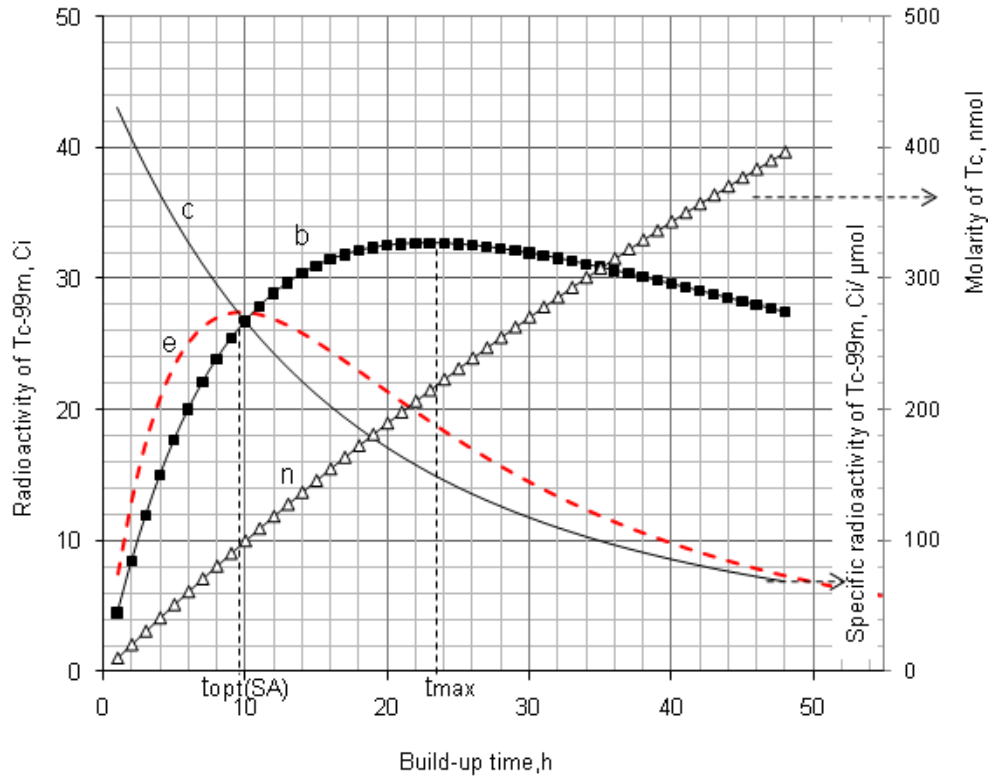
Figure 4. 99m Tc build-up optimisation of 99 Mo/ 99m Tc generator system: b, 99m Tc activity build-up (Referred to curve b of Figure 1); c, Specific radioactivity of 99m Tc (Referred to curve c of Figure 1); n, the total atom numbers N or molarities of Tc; e, Mean progress function of the 99m Tc-build-up versus specific activity of 99m Tc; t is the maximal build-up max is the optimal time value calculated in the optimisation time for nuclide 99m Tc; t opt ( SA ) process of the radioactivity build-up versus specific activity of the daughter nuclide 99m